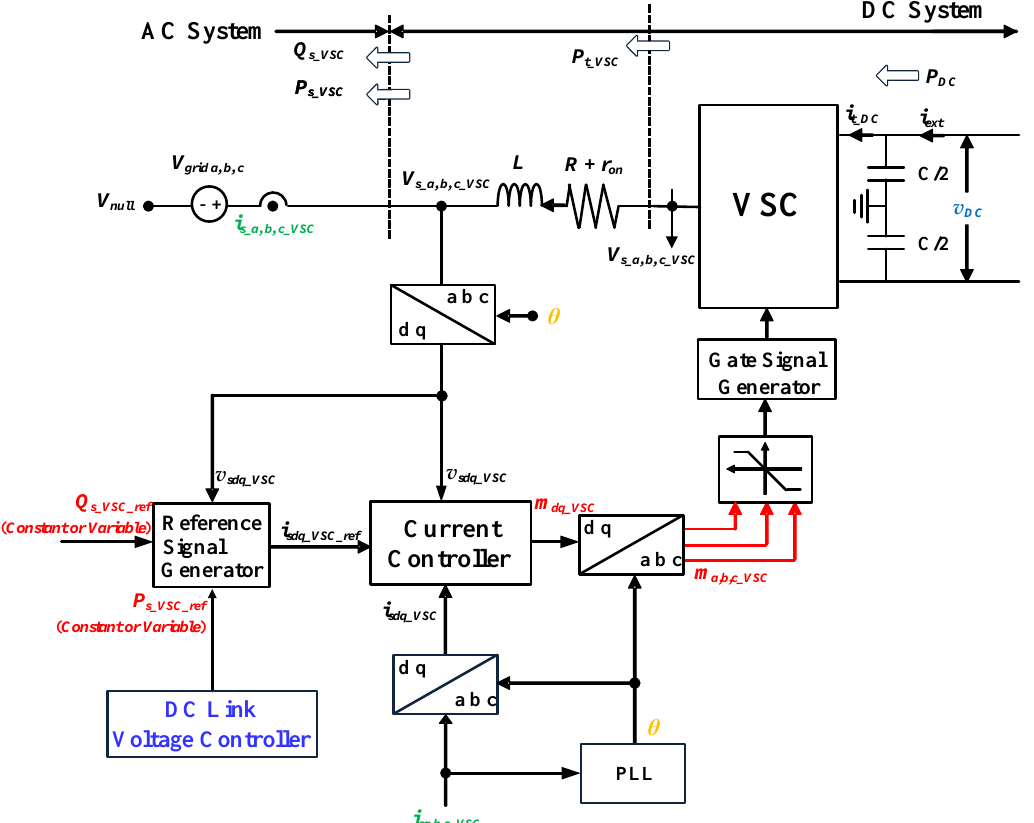
Figure 4. Control Block Diagram of VSC (Voltage-Sourced Converter) for Active and Reactive Power Control.